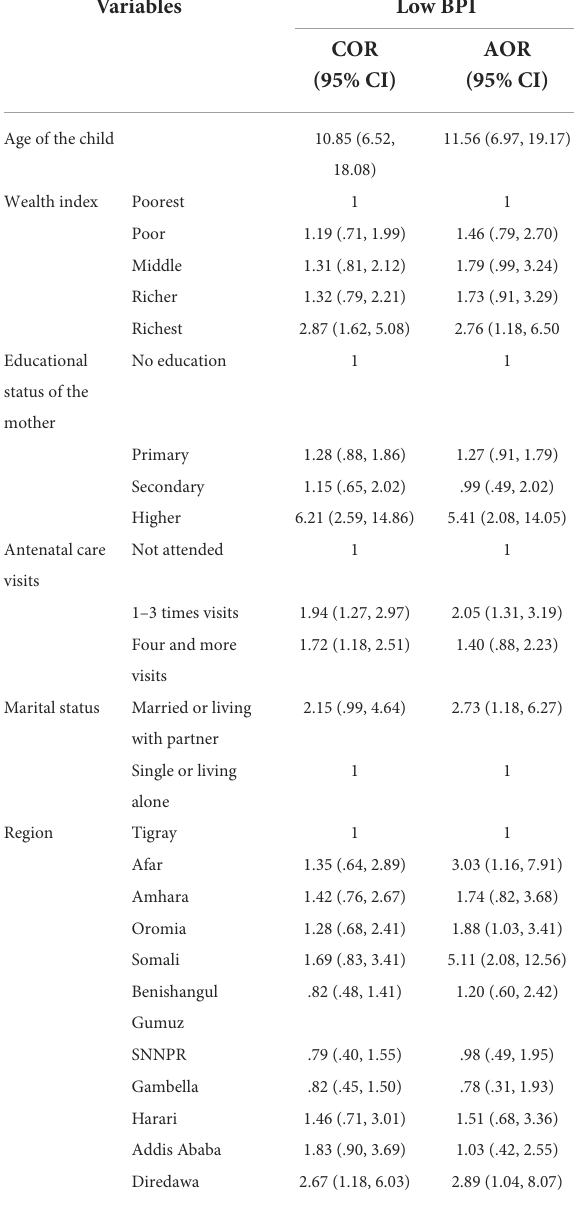
TABLE 3 Factors associated with the BPI in children aged 0–6 months in Ethiopia, the bivariate and multivariate multilevel logistic regression analysis ( n =